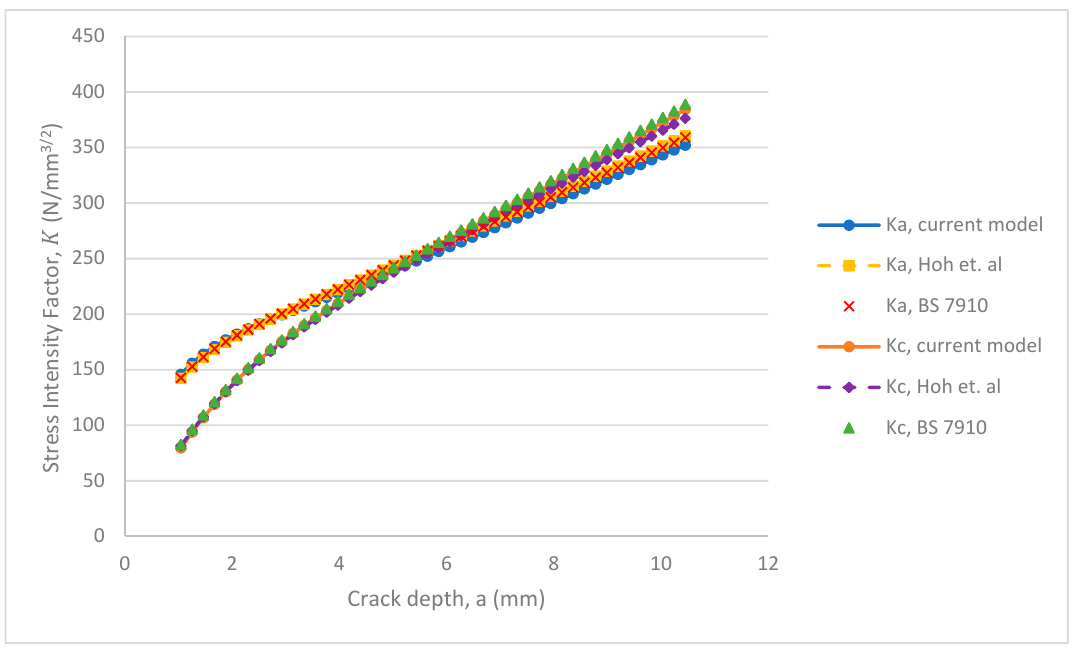
Figure 19. SIFs at the deepest point ( K a ) and surface point ( K c ) for an external semi-elliptical crack in a pipe under cyclic tension (initial a/c = 0.25).